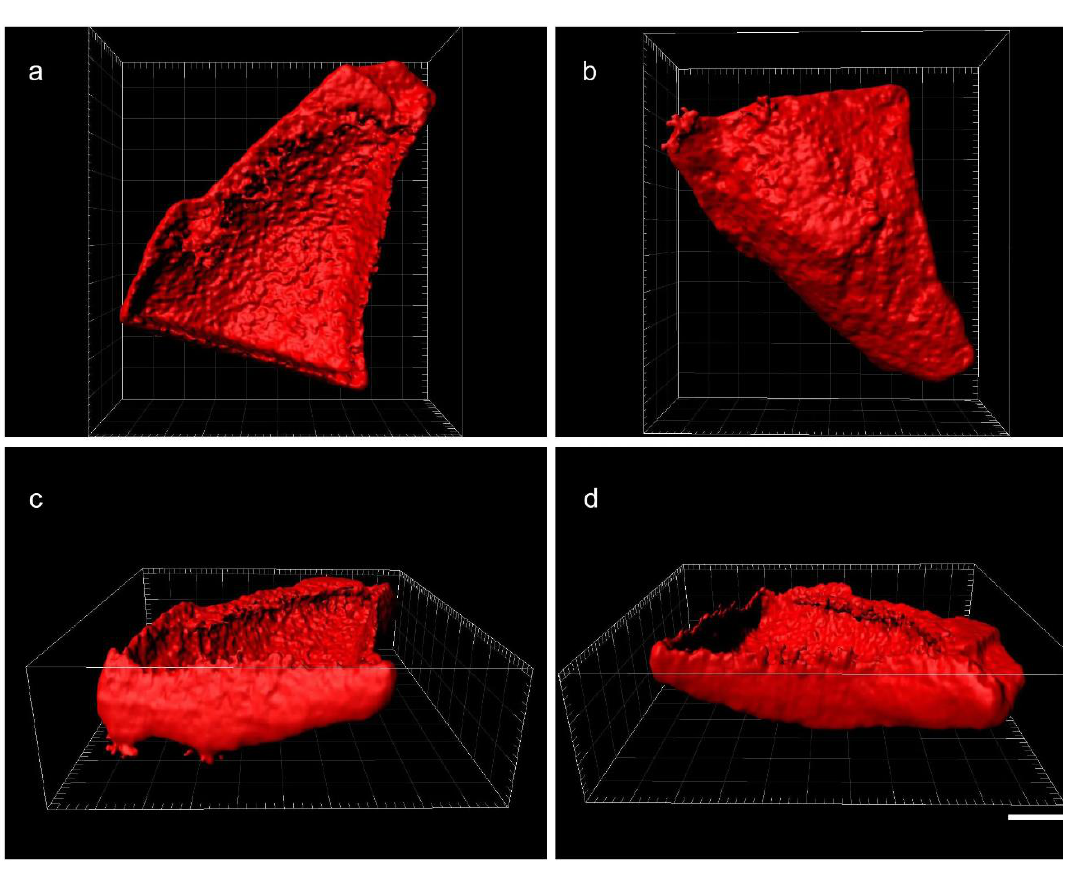
Figure 1. Reconstituted envelope of a MOF crystal coated with rhodamine-labeled H1 and observed in a confocal microscope, which is an interesting characterization strategy for confirming porous frameworks. Views from top ( a ), bottom ( b ), left ( c ) and right ( d ). To enable visualization inside MOF, the signal from the first layer was removed. Scale bar = 10 µm. Reproduced from Reference [18] with permission from the Nature Publishing Group, copyright 2015.